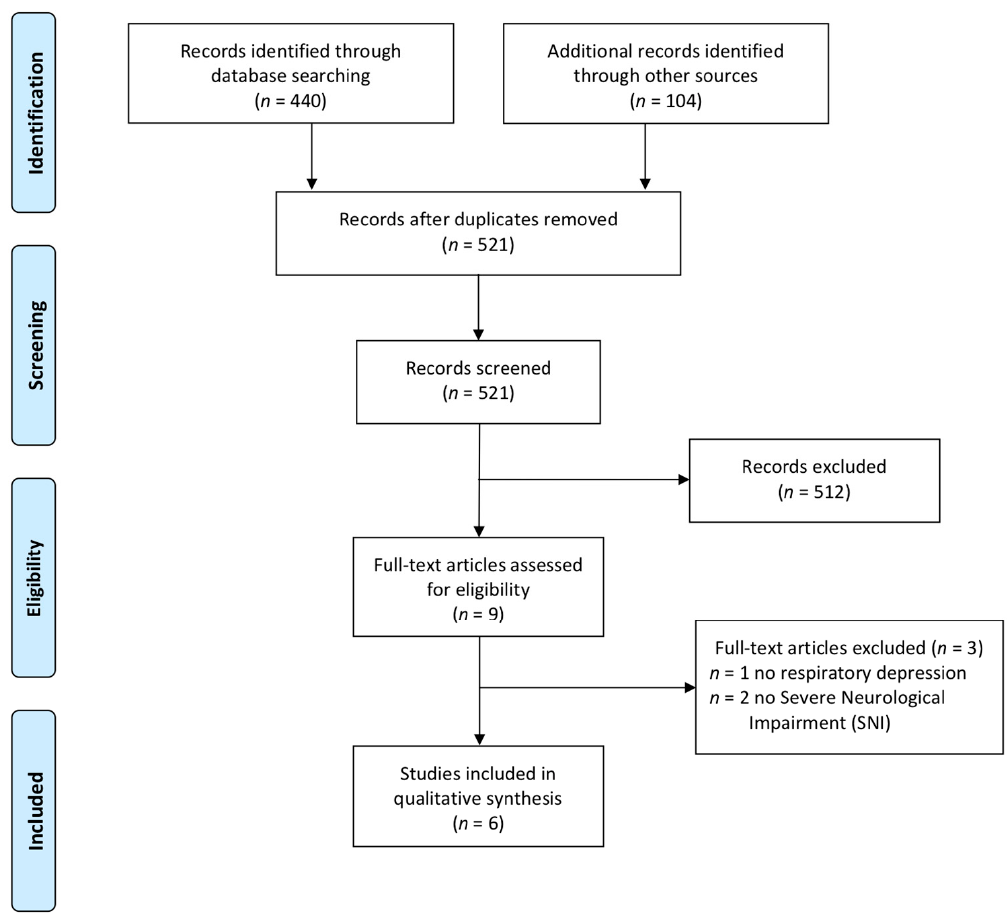
Figure 1. Flow chart of literature eligibility.